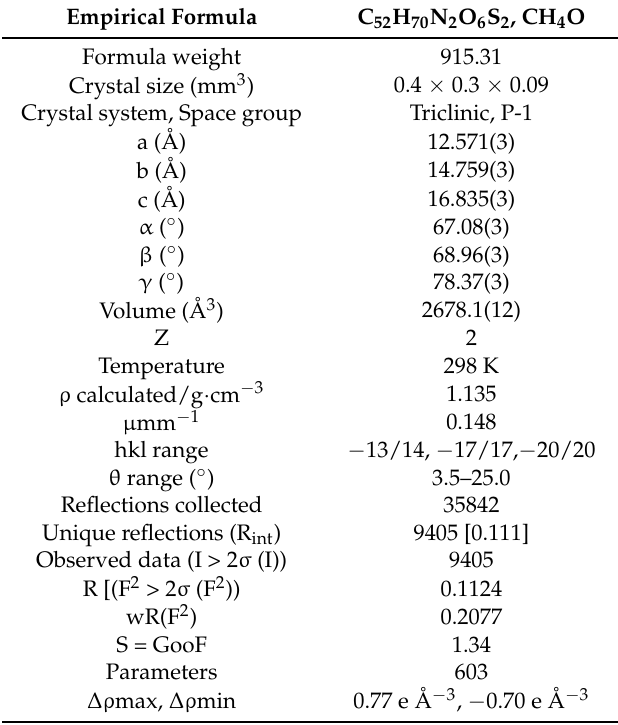
Table 3. Crystal data and structure refinement